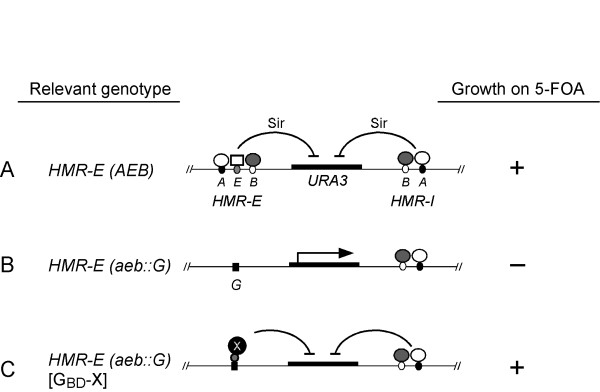
Esc4 was identified in an HMR targeted silencing screen. (A) In the presence of both wild-type silencers, HMR-E and HMR-I, the URA3 reporter gene at HMR is completely silenced in a SIR-dependent manner leading to growth in the presence of the drug 5-FOA. (B) When the HMR-E silencer is deleted (and here replaced with a binding site for the Gal4 protein (G)), the HMR locus is no longer silenced and the URA3 reporter gene is expressed. This loss of silencing at hmr::URA3 leads to no growth on 5-FOA media. (C) When the strain in (B) is transformed with a GBD plasmid (GBD-X) capable of causing targeted silencing, this leads to restoration of silencing at hmr::URA3 and growth on 5-FOA. In this way, a GBD hybrid protein library was screened for factors capable of targeted silencing. A GBD-Esc4(1–1070) hybrid was identified.